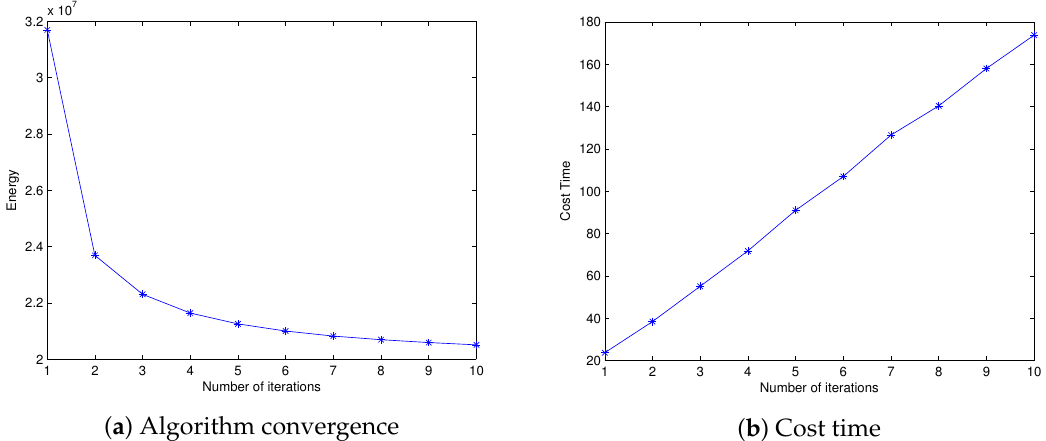
Figure 4. Energy value and cost time of simple linear iterative clustering (SLIC) under different iterations where the specified superpixel number K = 300. ( a ) The overall energy value decreases with the increase in iterations; ( b ) the cost time of the main process (k-means cluster and post-processing) increases approximately linearly with each